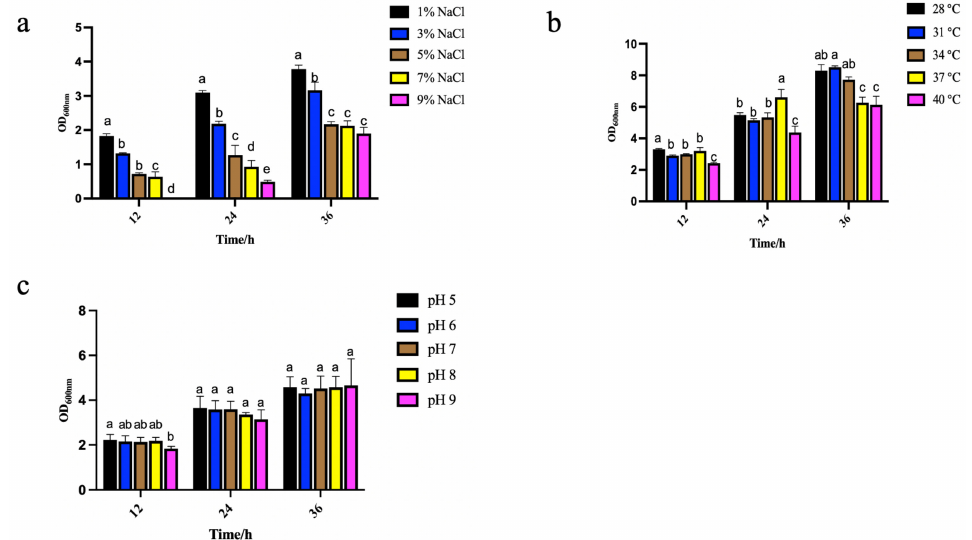
Figure 11. Effects of different temperatures ( a ), NaCl concentrations ( b ), and pH ( c ) on the growth of strain Y4. The different alphabetic superscripts in the same column are significantly different ( p < 0.05) based on Tukey’s multiple comparison